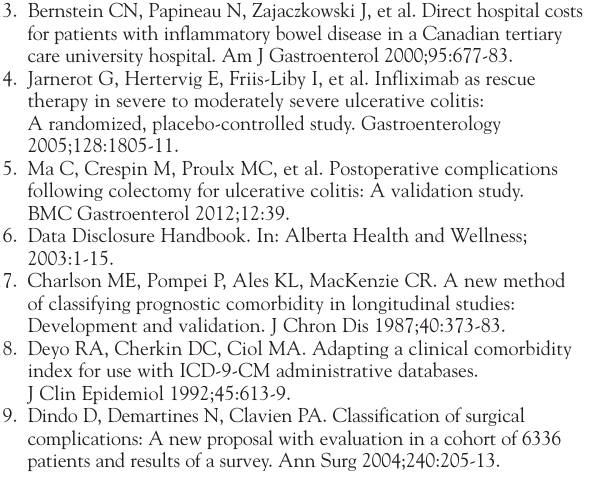
20. Statistics Canada. Consumer Price Index. <www.statcan.gc.ca/tables- tableaux/sum-som/l01/cst01/econ09a-eng.htm> (Accessed August